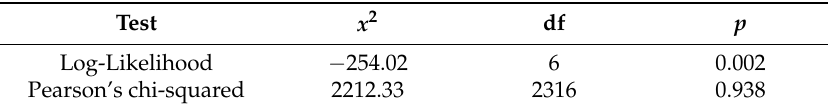
Table 3. Model evaluation and goodness of fit